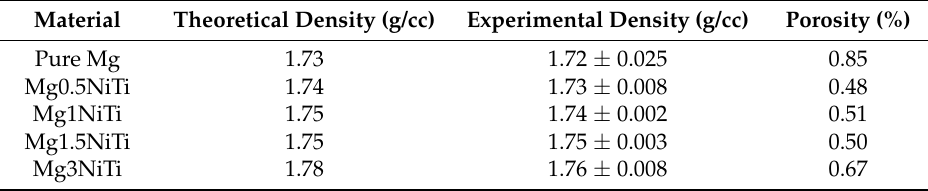
Table 1. Density and porosity of pure Mg and Mg-NiTi